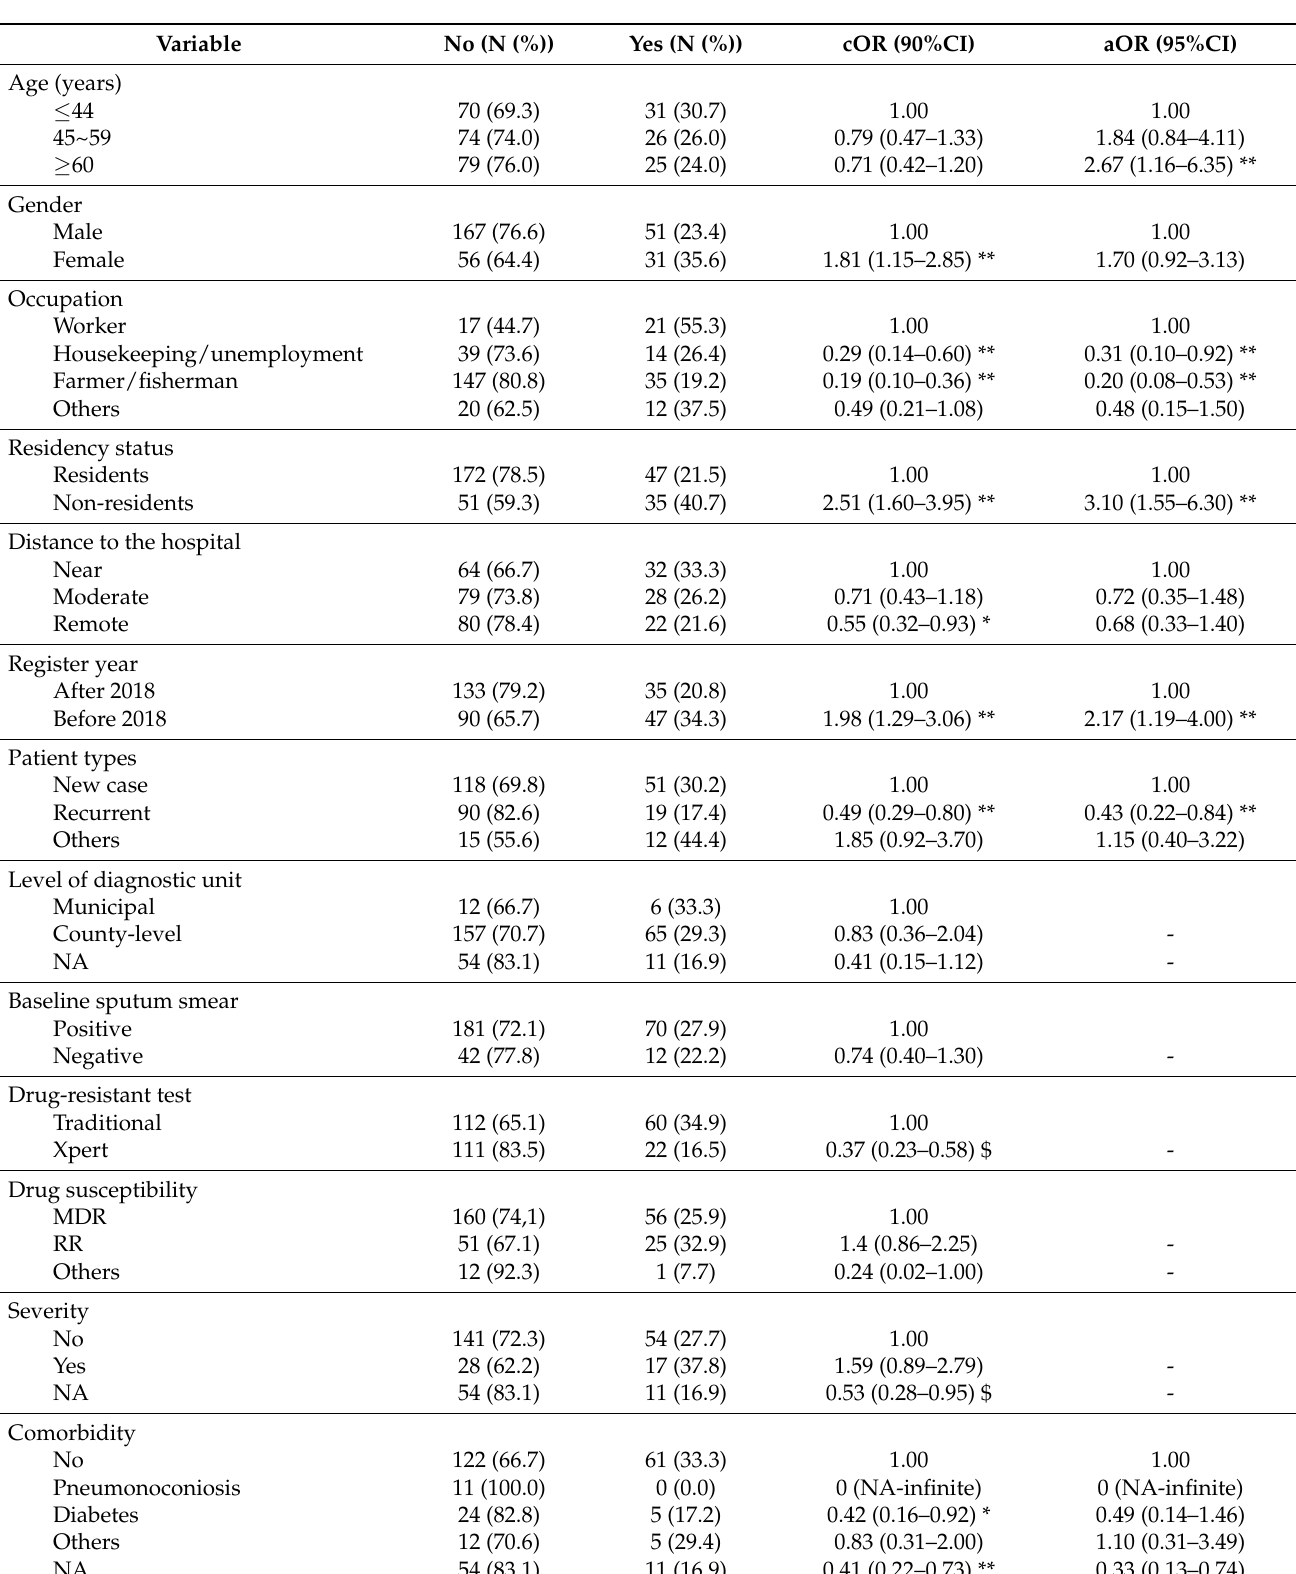
Table 3. Association of clinical and socio-demographic factors with pre-treatment attrition among MDR/RR-TB patients (N =